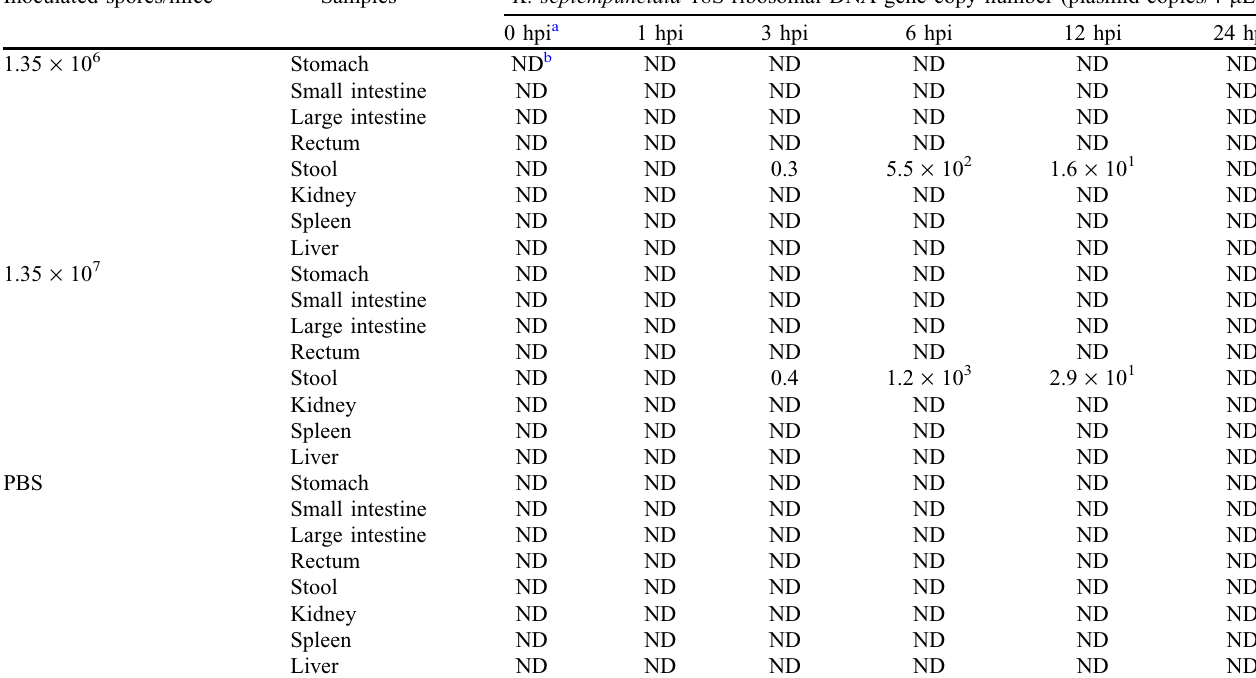
Table 1. Kudoa septempunctata 18S ribosomal DNA gene copy numbers in the various organs and stools of mice intragastrically administered with K. septempunctata spores.